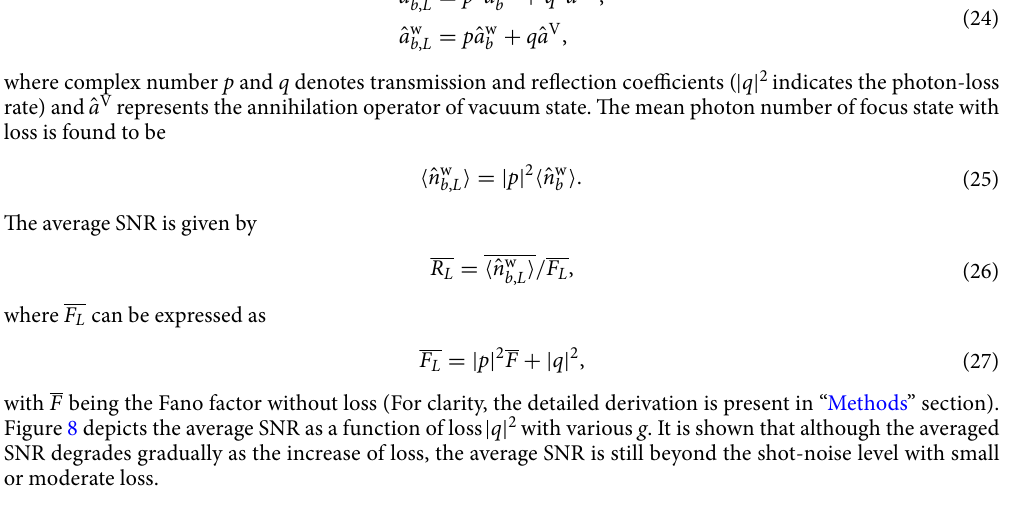
Figure 7. The average Fano factor F univ of the focused mode as a function of means the “coherent” intensity of input beam and